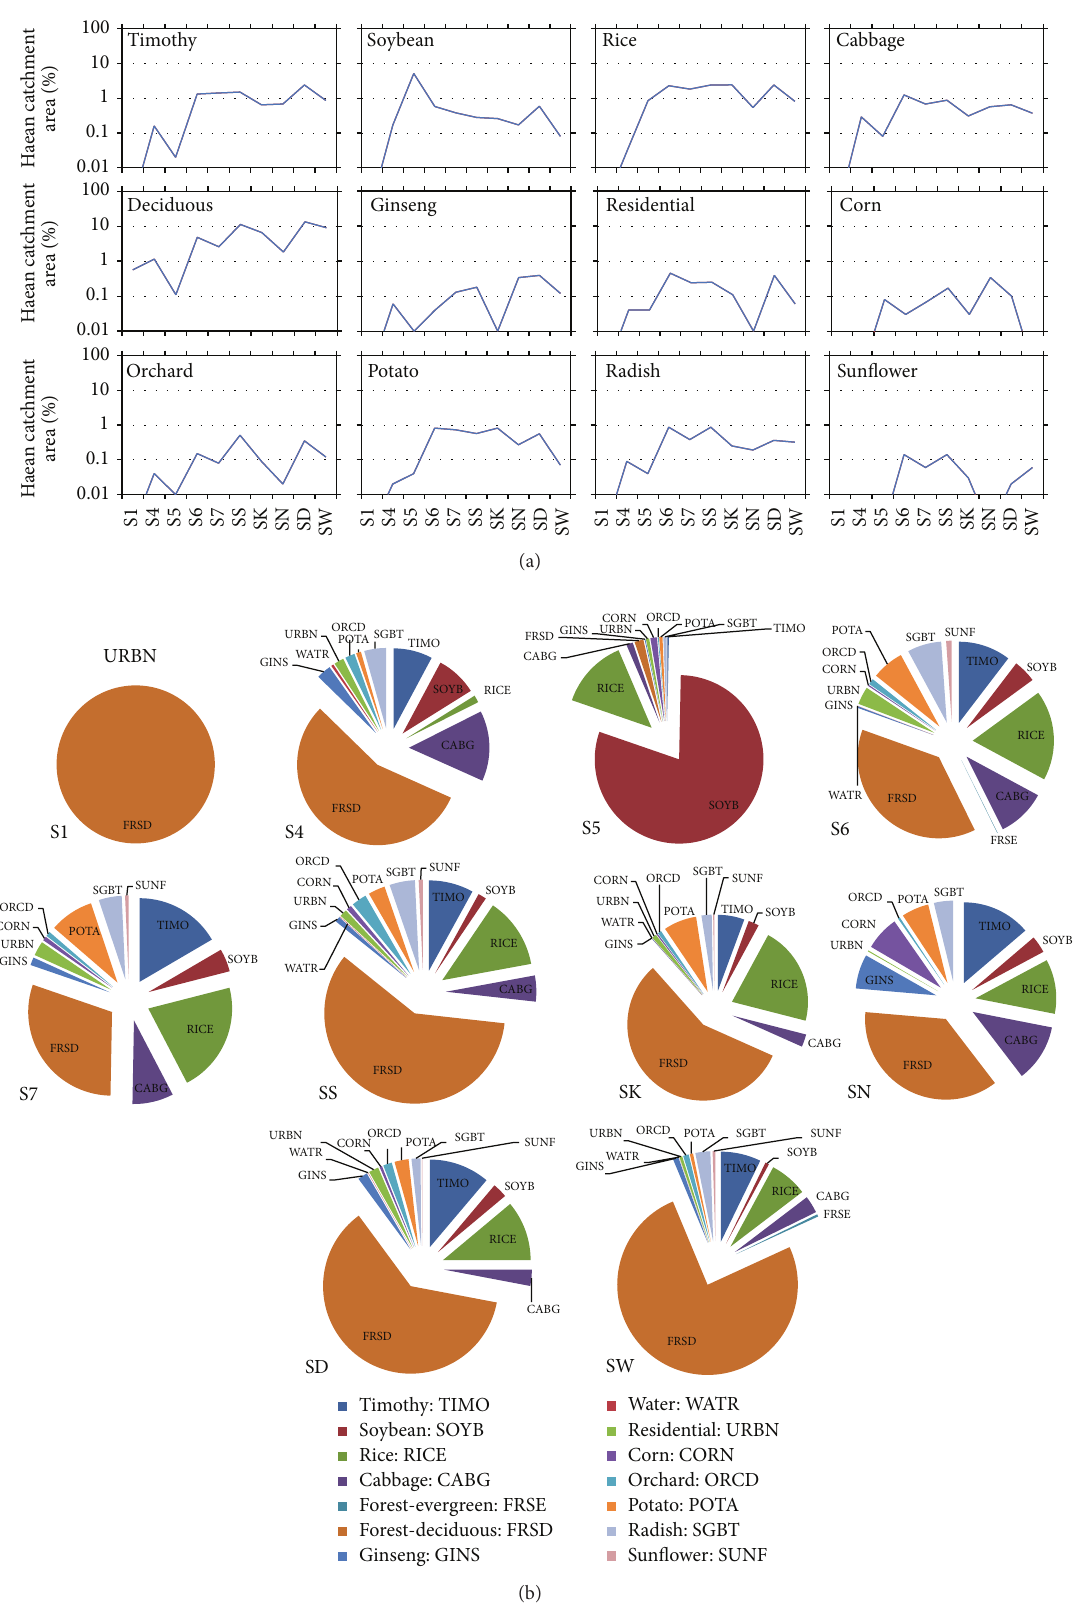
Figure 8: (a) Percentage of aggregated Haean catchment LULC for each of the monitoring location drainage areas. The LULC for inland water and deciduous evergreen forest was negligible and therefore was not included. (b) Land use classification for each of the surface water monitoring location drainage